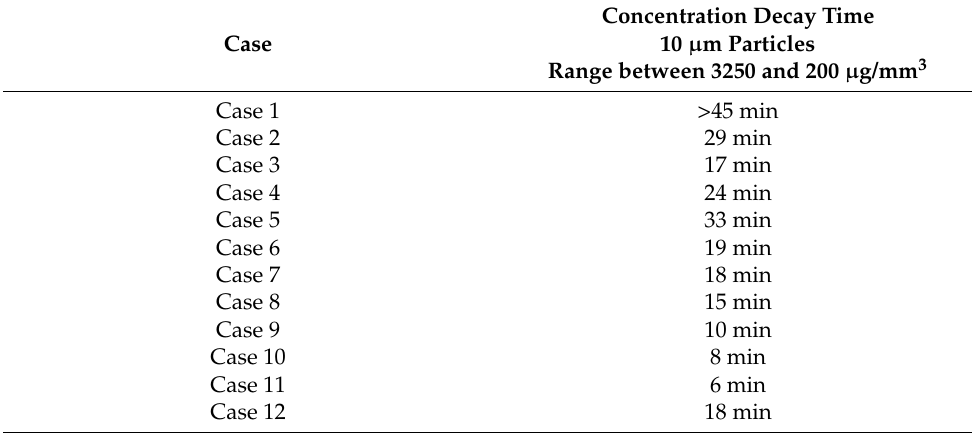
Table 3. Aerosol concentration decay time to 10 µ m/mm 3